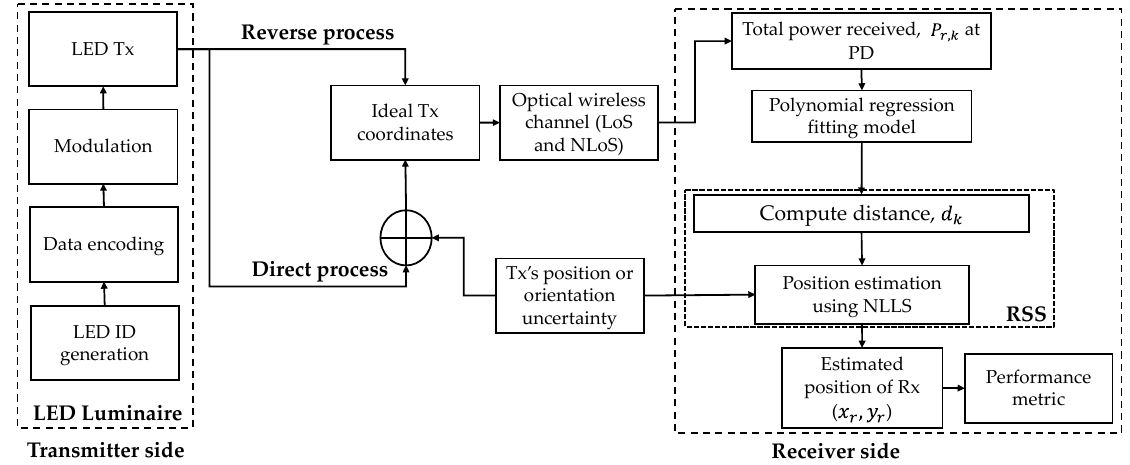
Figure 3. Block diagram of the proposed system.